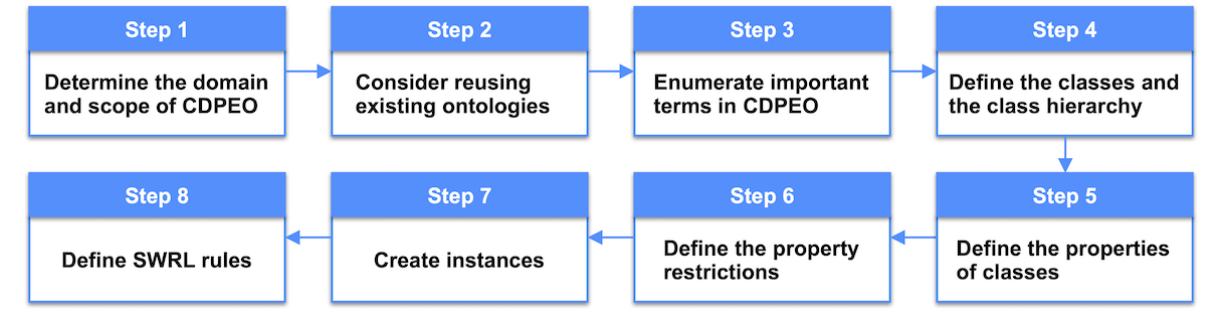
Figure 2. Chronic Disease Patient Education Ontology construction